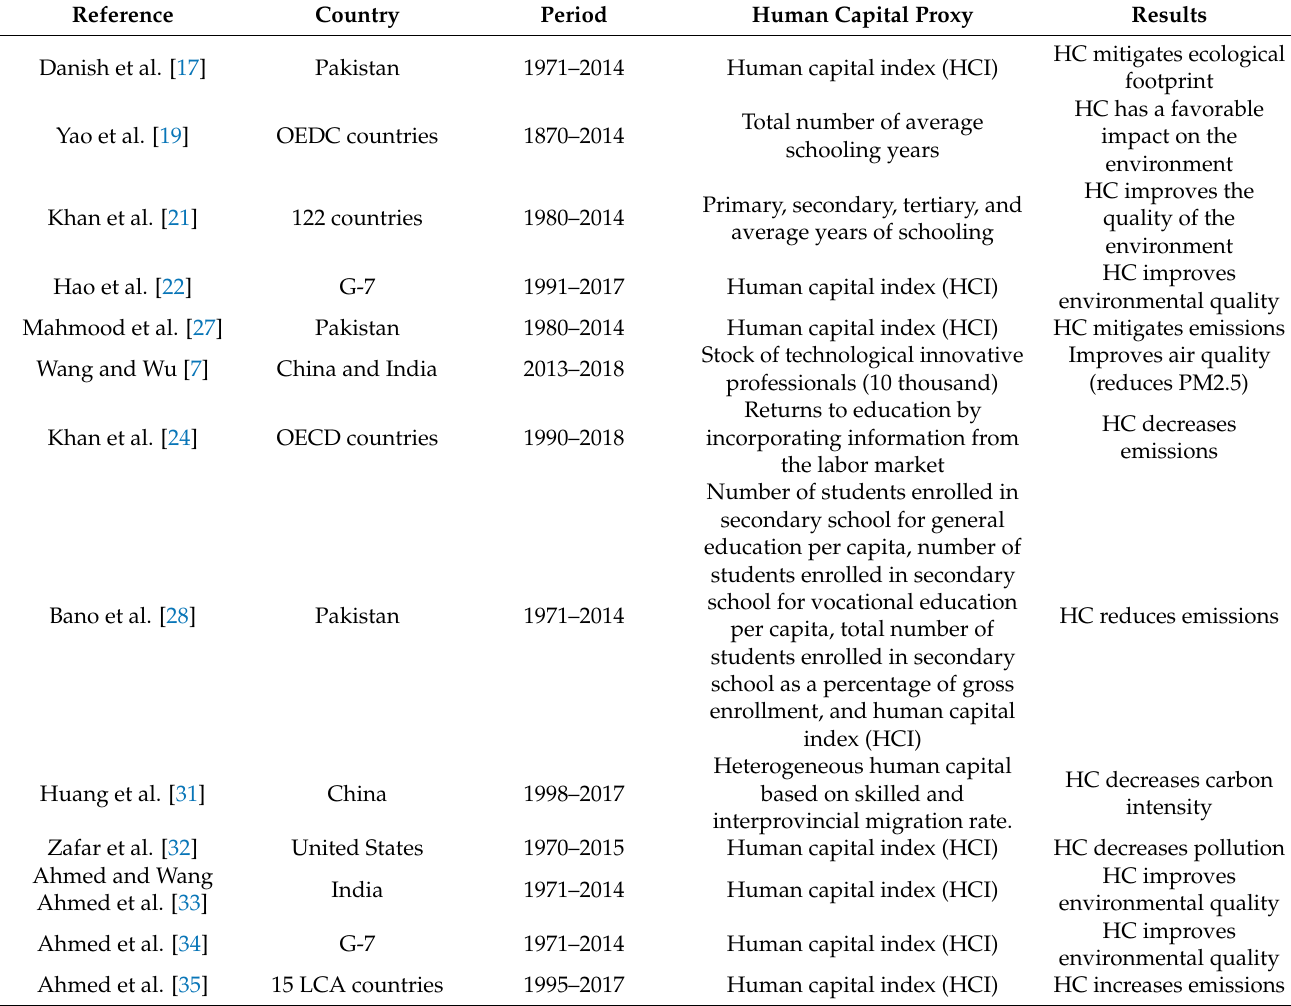
Table 1. Summary of literature on human capital and environmental quality